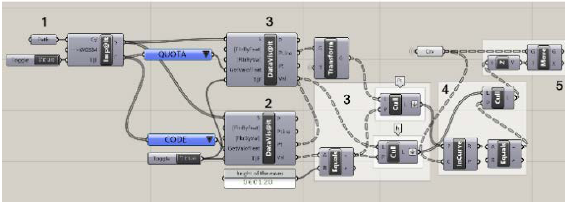
Figure 7. Instructions to describe the volumes of the